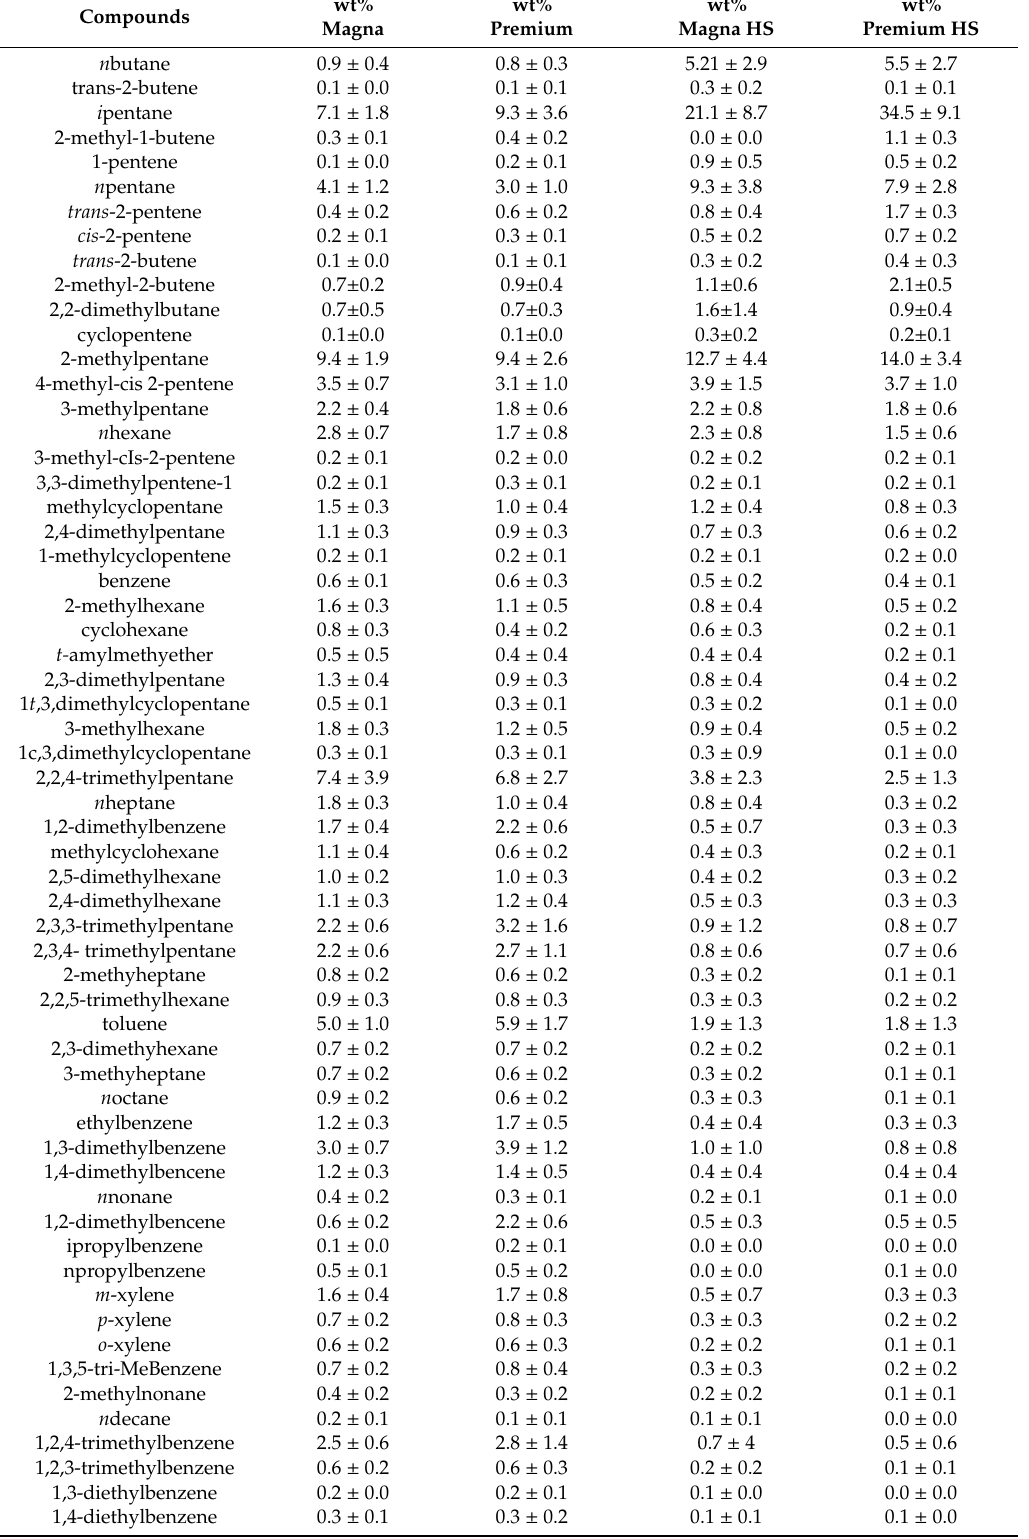
Table 5. Composition of the whole and head space (HS) gasolines expended in Mexico